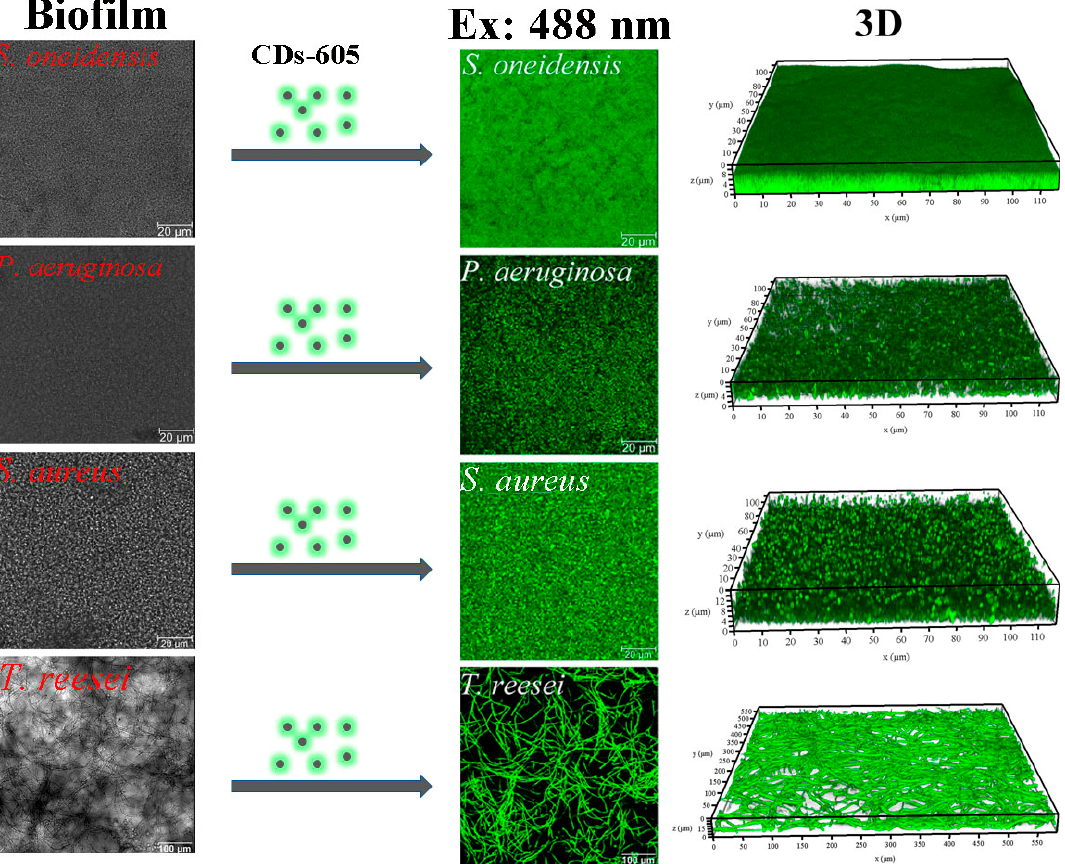
Figure 5. Confocal imaging results of biofilms formed by S . oneidensis , P . aeruginosa , S . aureus , and T . reesei using CDs-605. Reproduced with permission from [70]. Copyright Royal Society of Chemistry, 2017.